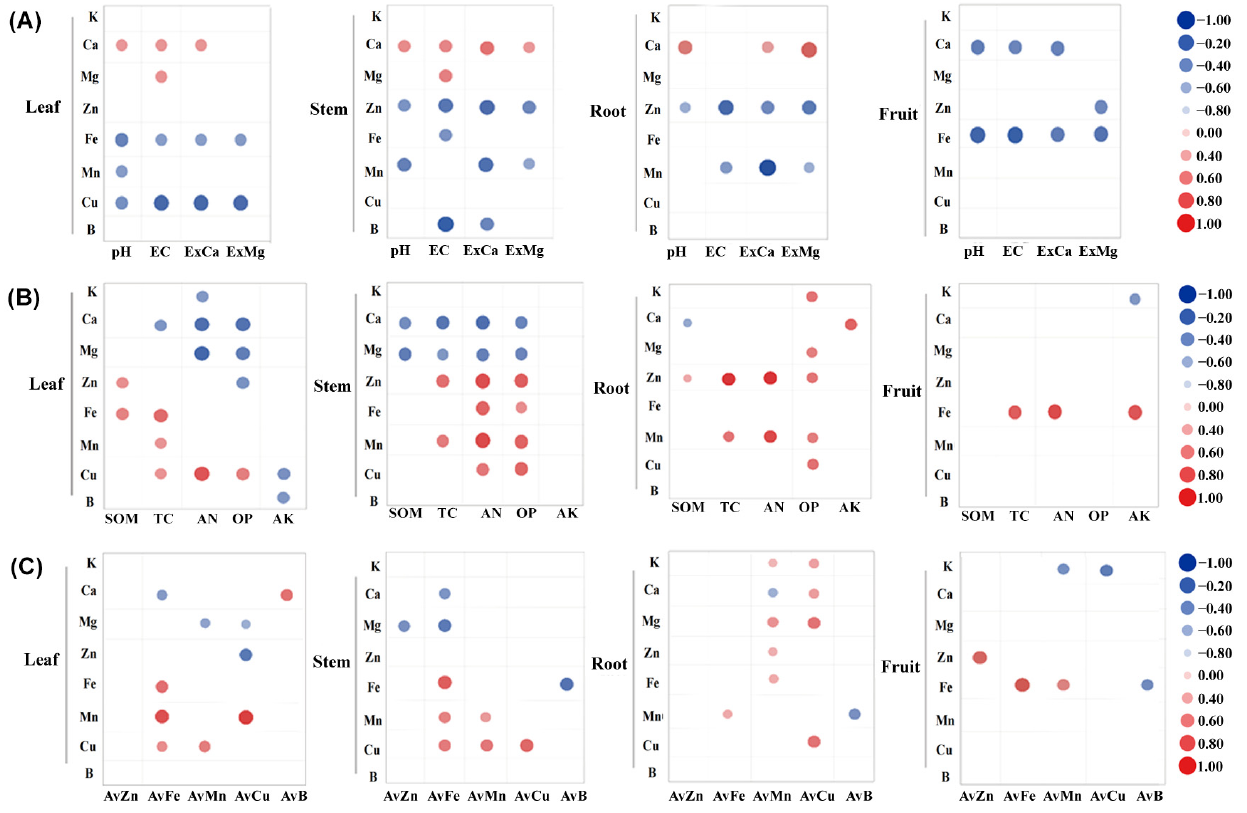
Figure 3. The correlation between nutrients in different parts of citrus and soil salinity indexes ( A ), soil available nutrients of macro-elements ( B ), and soil available nutrients of microelements ( C ), respectively.